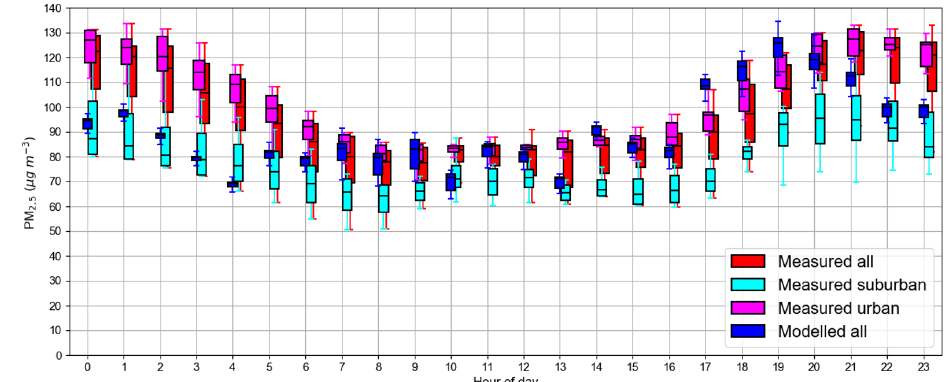
Figure 13. Variations in site-specific campaign period mean measured (red) and modelled (blue) PM 2 . 5 concentrations across all monitoring network stations for each hour of the day. Measurements sub-divided to highlight the variation between suburban (cyan) and urban (pink) monitoring network stations